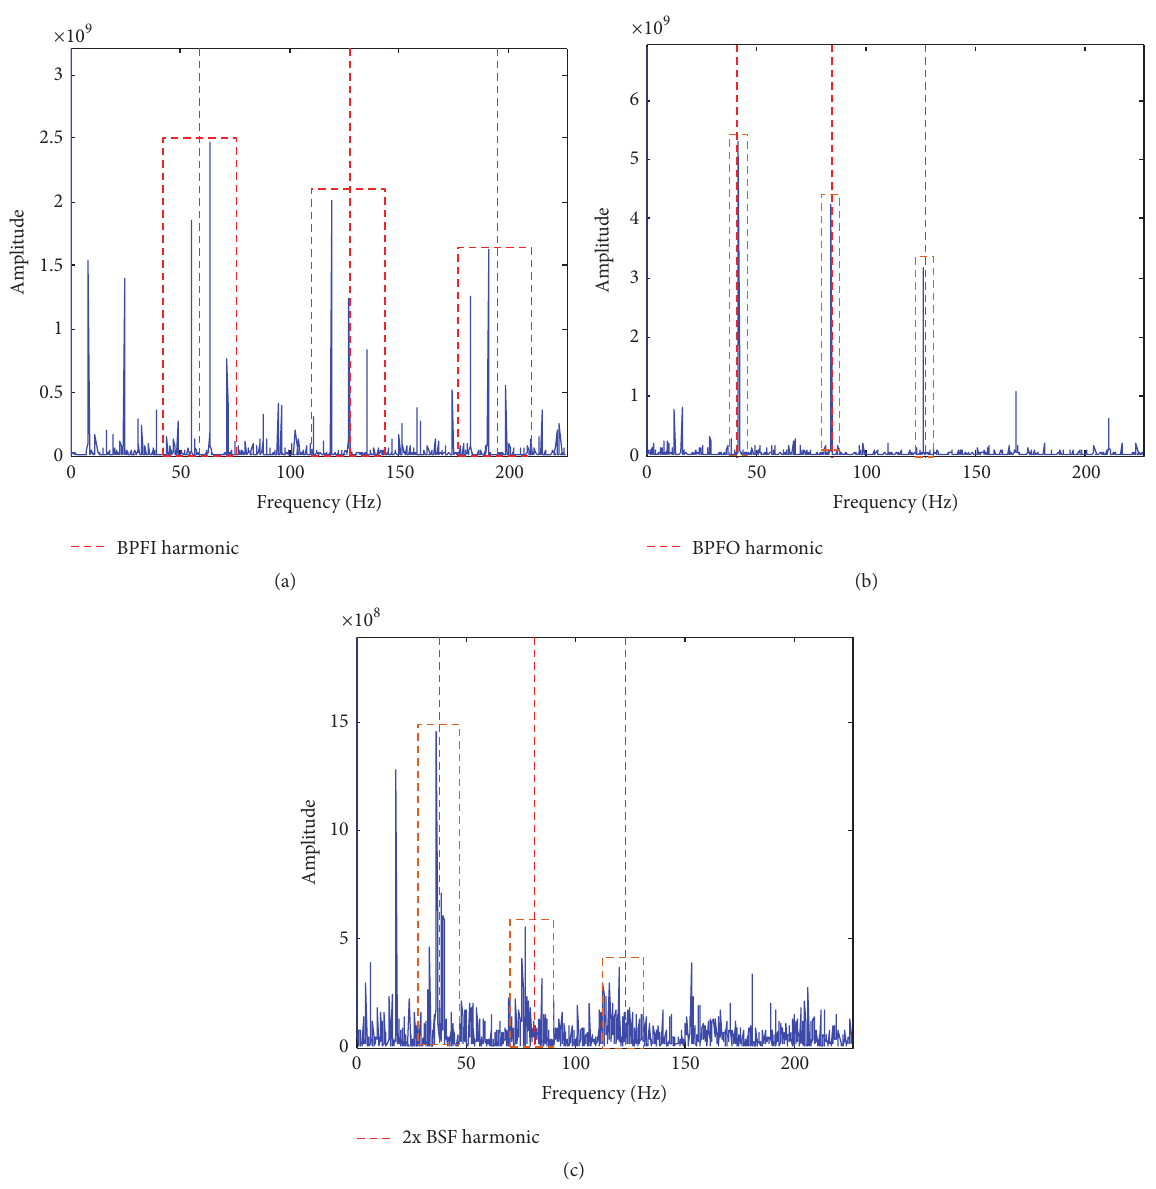
Figure 5: Fault frequency regions up to three harmonics at (a) inner, (b) outer, and (c) roller fault frequency.